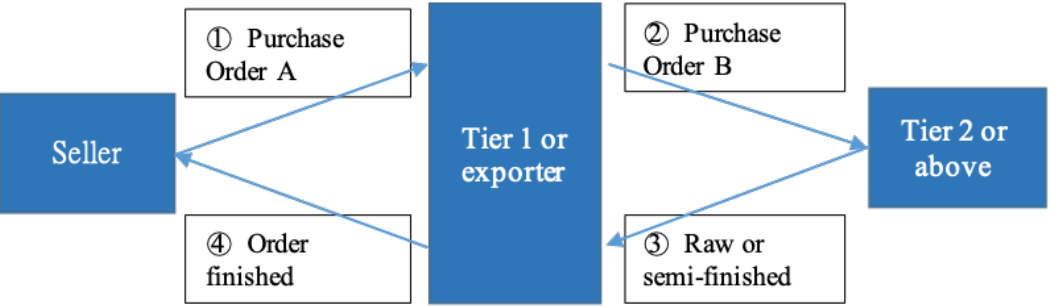
Figure 5. Purchase order.